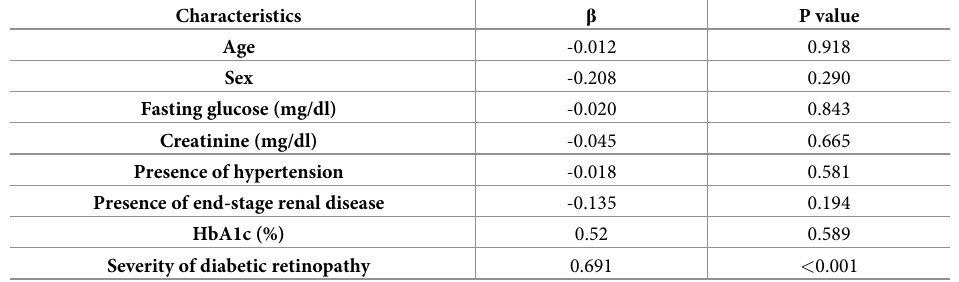
P value < 0.001 is set for statistical